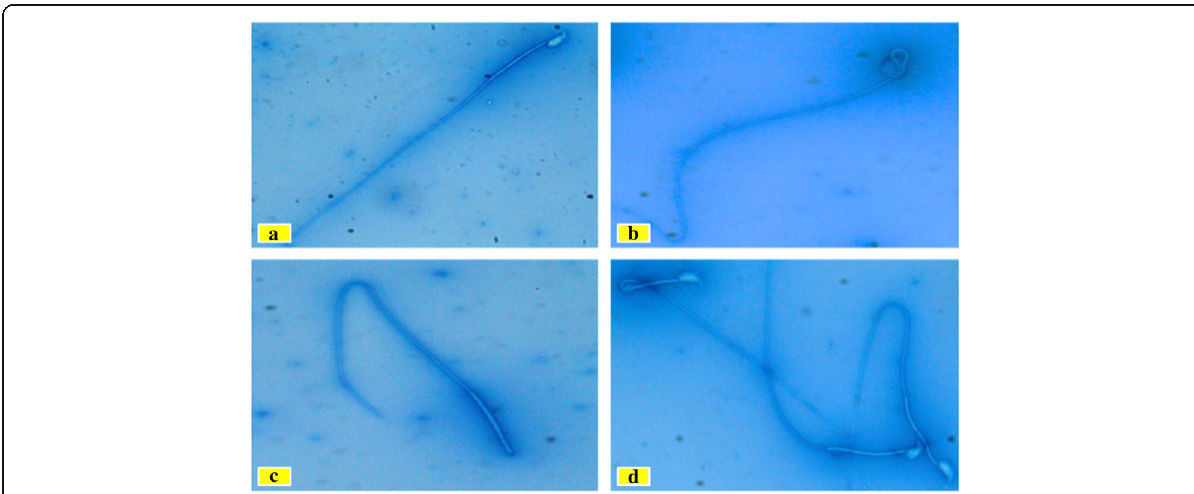
Fig. 1 Evaluation of sperm morphology profiles by using aniline blue staining. a Healthy sperm. b Sperm with curvature medial anomalies. c Sperm with amorphous malformations (without head). d Sperm with curvature tail